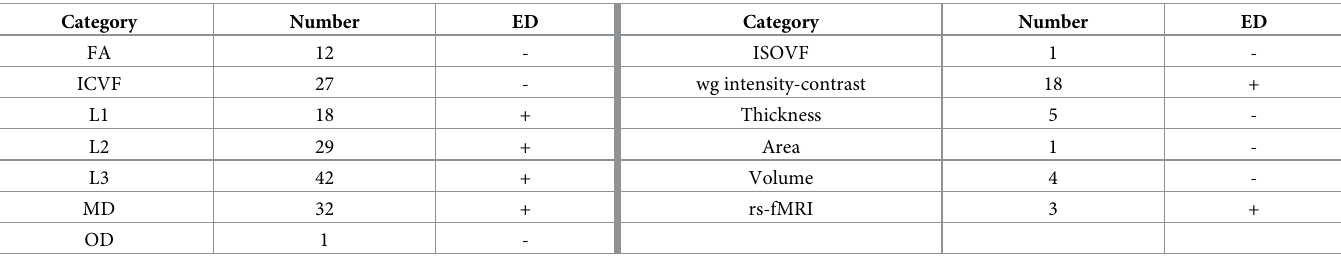
Table 1. The significant IDPs categorized by modality. ED: effect direction whether it is positive (+) or negative (-). Category